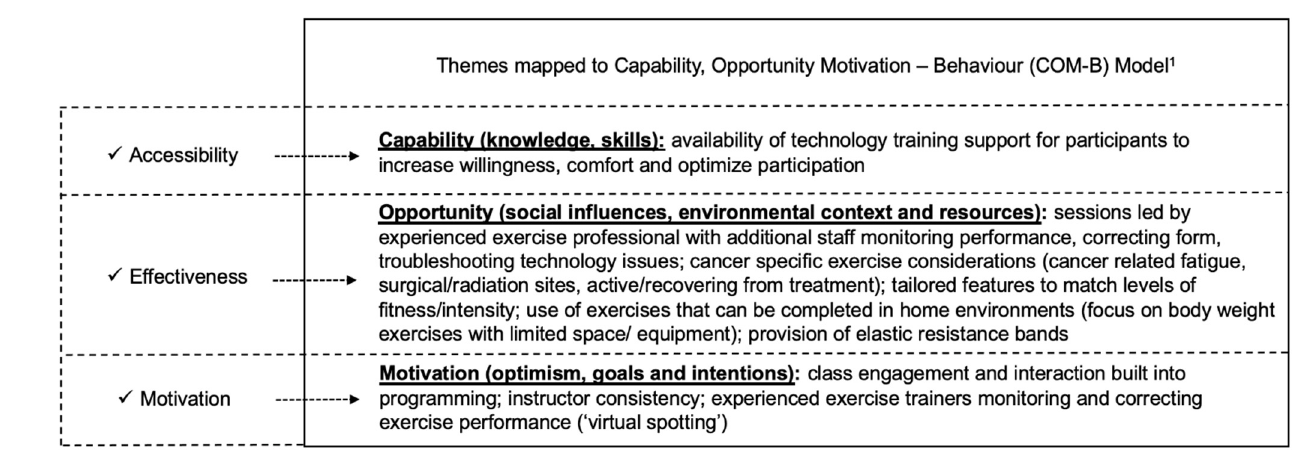
Figure 4. Thematic Findings Mapped to COM-B Model with Clinically Actionable Items to Support Virtual Exercise Implementation